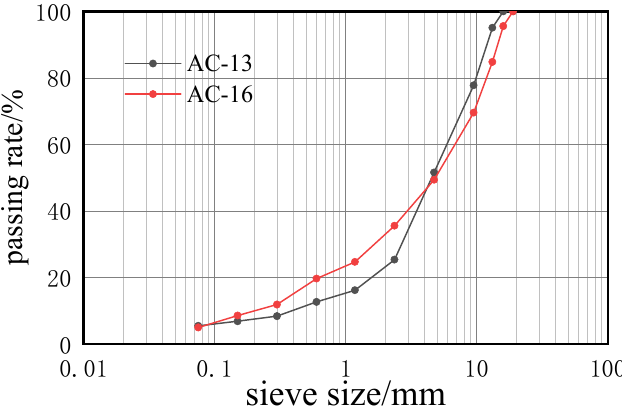
Figure 1. Aggregate gradation. The sand sample comes from aeolian sand-covered on the road surface in the desert area of Xinjiang. In order to explore the different particle size content and microscopic morphology of aeolian sand, the particle size analysis of aeolian sand was carried out, and the particle size distribution of the sample was tested with a laser particle size analyzer (instrument model: Master-sizer 2000) (Malvern Instruments Ltd., Worcestershire, UK). The results are shown in Figure 2 by using the field emission scanning electron microscope (Quanta FEG 250) (FEI Co., Hillsboro, OR, USA). The morphology of aeolian sand under different magnifications is shown in Figure 3.